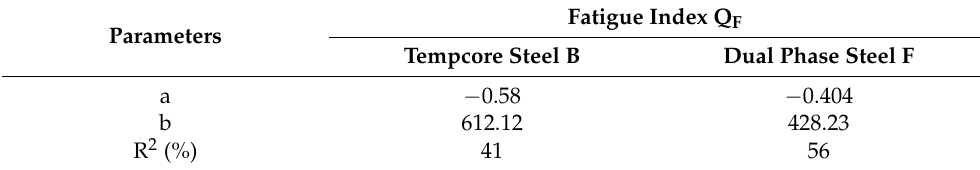
Table 11. Parameters determined by regression analyses for both types of steel